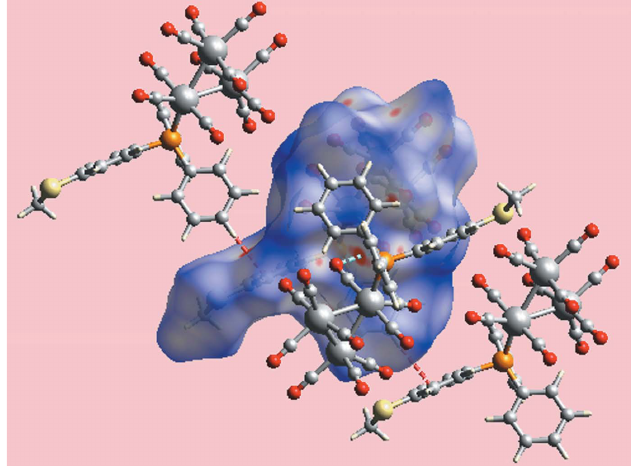
Figure 5 A view of the Hirshfeld surface of (I) mapped over d norm in the range (cid:5) 0.090 to +1.204 au highlighting O (cid:2)(cid:2)(cid:2) O and C (cid:2)(cid:2)(cid:2) H/H (cid:2)(cid:2)(cid:2) C contacts by sky-blue and red dashed lines,